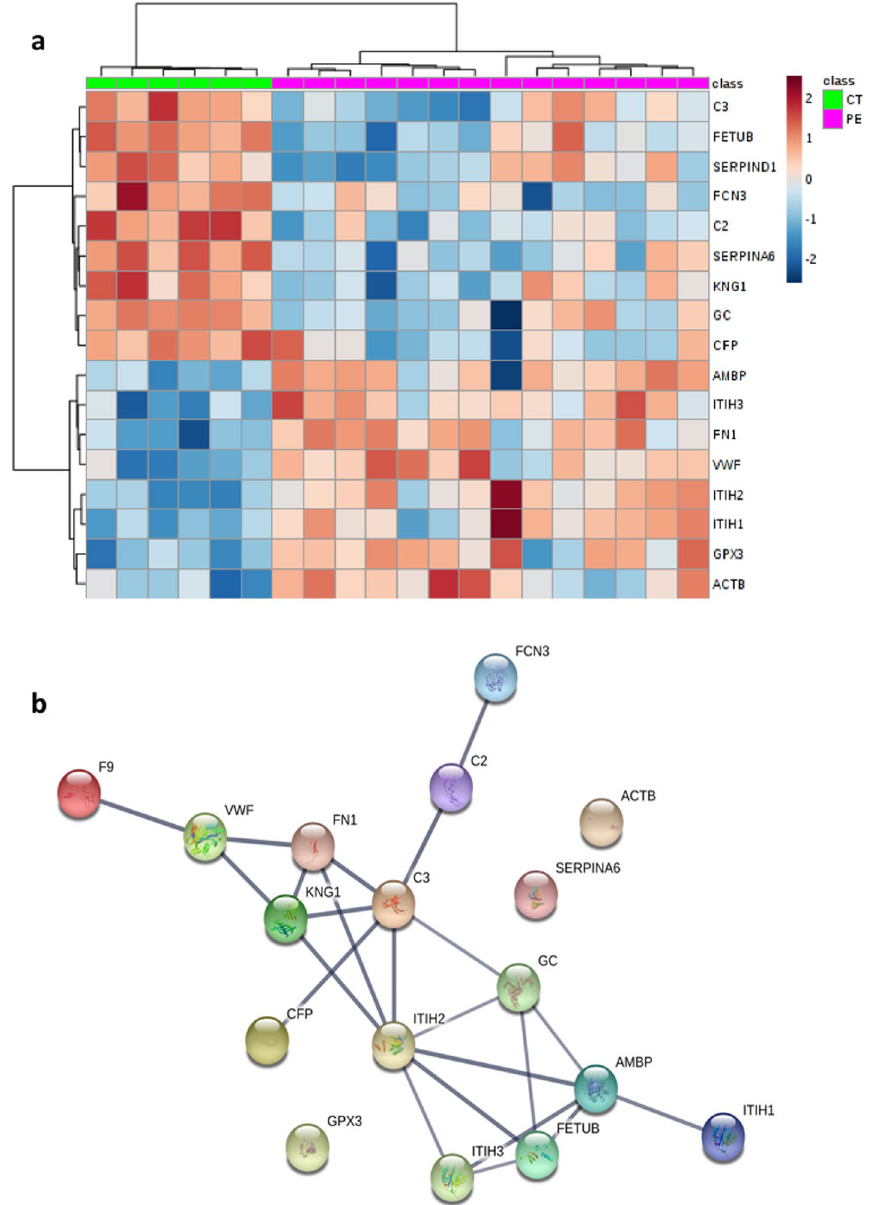
Figure 2. ( a ) Unsupervised hierarchical clustering based on the top 17 proteins selected from univariate analysis performed using Metaboanalyst 4.0 (http://www.metab oanal yst.ca/). A z-score transformation was performed on the intensity of each protein across all samples and each sample z-score is displayed in the heatmap. Proteins (in rows) and samples (in columns) are clustered by Euclidean distance and Ward linkage. ( b ) Protein–Protein Interaction network for these 17 proteins obtained using STRING database 11.00 (https ://strin g-db.org/). Nodes represent proteins and edges interaction between proteins. The thickness of the edge indicates the degree of confidence prediction of the interaction. Only interactions with a high confidence score (> 0.7) were considered. F9 coagulation factor IX, C3 complement C3, CFP properdin, VWF Von Willbrand factor, KNG1 kininogen-1, FETUB fetuin-B, AMBP protein AMBP, ITIH1 inter-alpha-trypsin inhibitor heavy chain H1, C2 complement C2, SERPINA6 corticosteroid-binding globulin; FN1 fibronectin type III domain containing, ACTB actin, cytoplasmic 1, ITIH2 inter-alpha-trypsin inhibitor heavy chain H2, GPX 3 Glutathione peroxidase 3, GC vitamin D-binding protein, ITIH3 inter-alpha-trypsin inhibitor heavy chain H3, FCN3